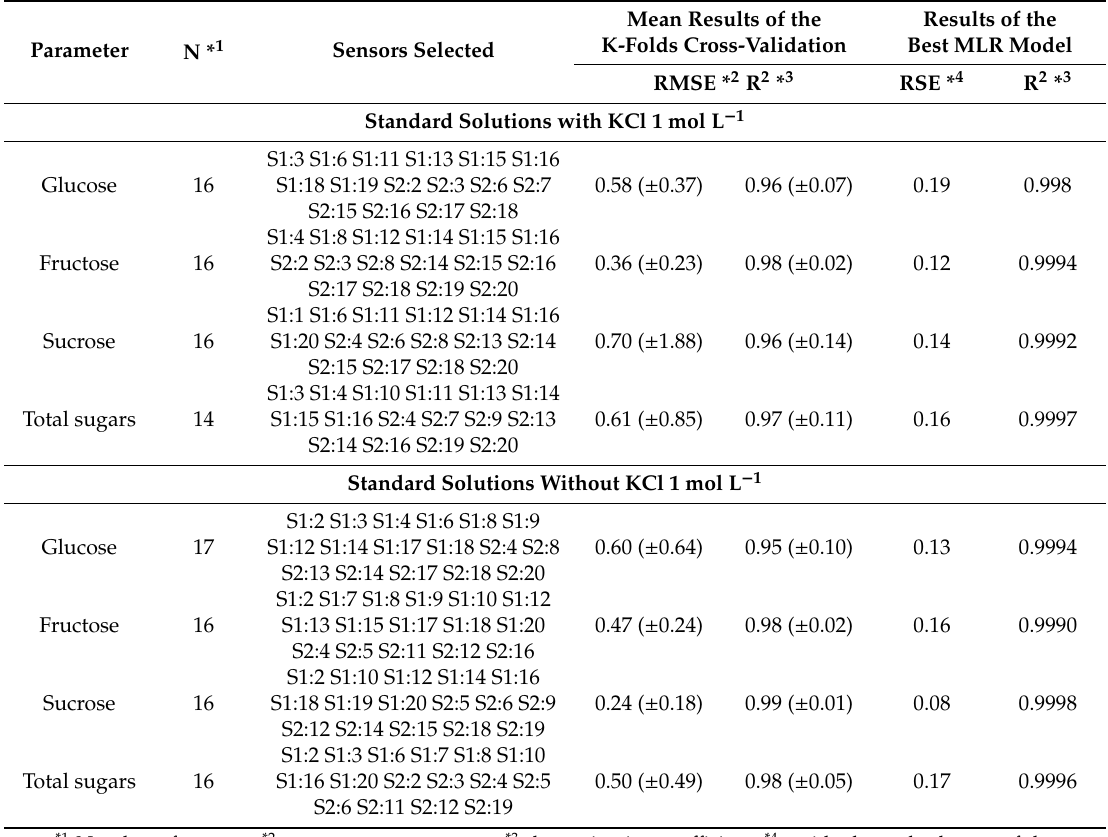
Table 3. The sub-set of sensors selected and results for the multiple linear regression (MLR) model of each dependent variable.